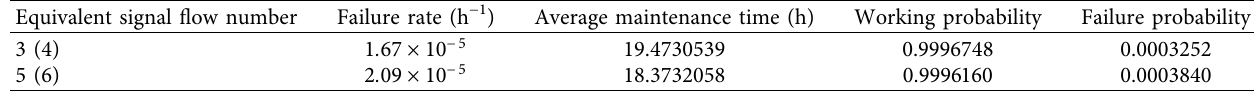
Table 6: Reliability parameters of operators 3 (4) and 5 (6).